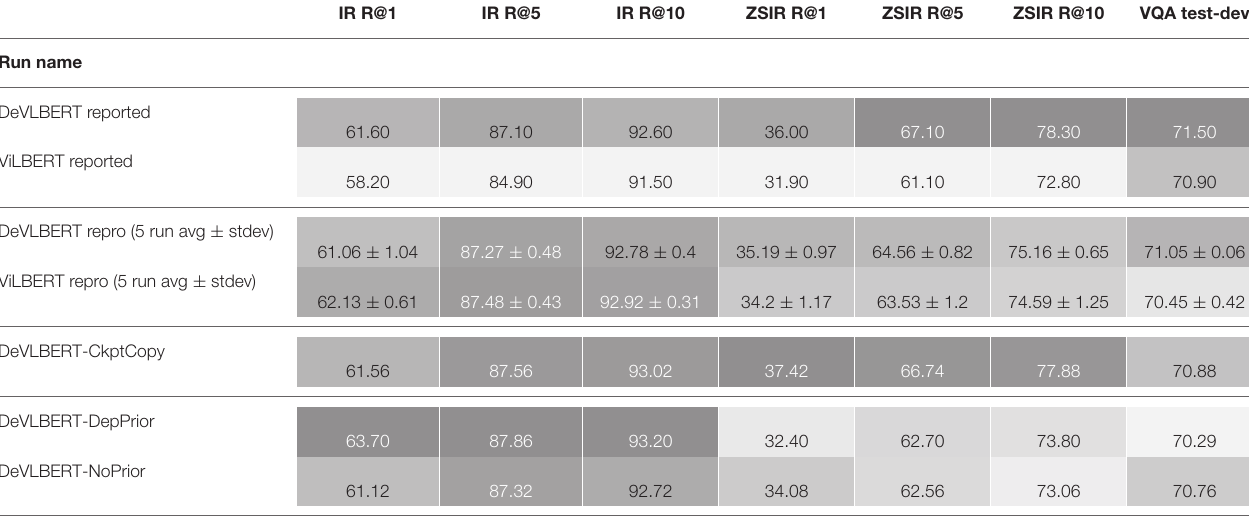
TABLE 4 | Scores on downstream tasks: top-1 recall, top-5 recall and top-10 recall for Image Retrieval (IR R@1, IR R@5, IR R@10) and zero-shot image retrieval (ZSIR R@1, ZSIR R@5, ZSIR R@10), and accuracy on the test-dev split for Visual Question Answering (VQA).